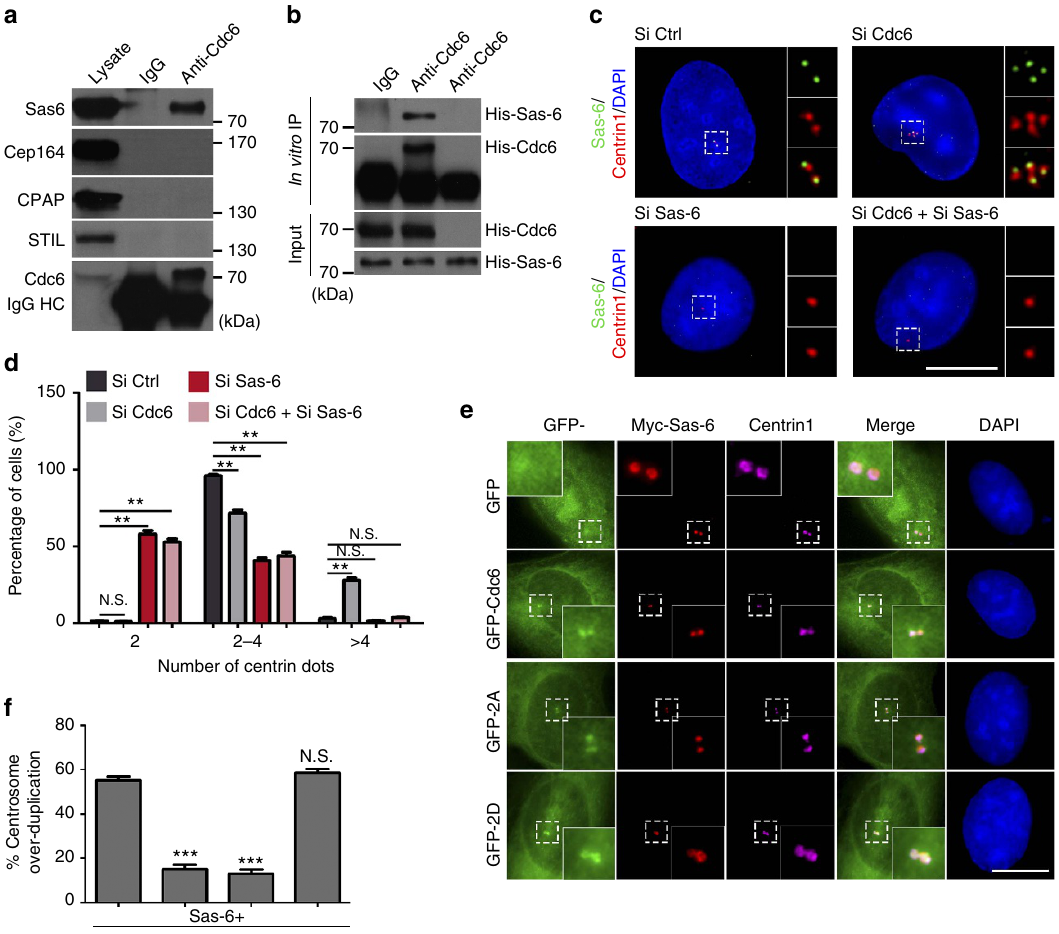
Figure 6 | Cdc6 restrains centrosome duplication via inhibiting Sas-6 in a Plk4 phosphorylation regulated way. ( a ) Endogenous Cdc6 interacts with Sas-6 in cells. HEK293 total cell extract was immunoprecipitated with a Cdc6 antibody, and probed with Cdc6, Sas-6, Cep164, CPAP and STIL antibodies. ( b ) Cdc6 directly binds Sas-6 in vitro . In vitro transcribed and translated His-tagged Sas-6 was incubated with or without in vitro transcribed and translated His-tagged Cdc6. His-Cdc6 was then immunoprecipitated with a Cdc6 antibody. The bound proteins were analysed with Cdc6 and Sas-6 antibodies. ( c ) Simultaneous depletion of Sas-6 eliminates the Cdc6 depletion-induced centriole amplification. U2OS cells were transfected with control siRNA, Cdc6 siRNA or Sas-6 siRNA; or co-transfected with Cdc6 siRNA and Sas-6 siRNA. The cells were then stained with centrin1 (red) and Sas-6 (green) antibodies to identify the cells with efficient depletion of Sas-6. ( d ) Quantitation of cells with indicated centrin1-positive dots number in c . Approximately 100 cells were counted per sample, and three independent experiments were conducted. ( e ) Cdc6 WTor Cdc6 2A mutant, but not Cdc6 2D mutant, suppresses the Sas-6-induced centriole amplification. Myc-tagged Sas-6 was co-transfected with GFP, GFP-tagged Cdc6 WT or GFP-tagged Cdc6 2A or 2D mutant for 28h. The cells were then stained with Myc and centrin1 antibodies. ( f ) Quantitation of cells with 4 4 centrioles in e . Approximately 100 cells were